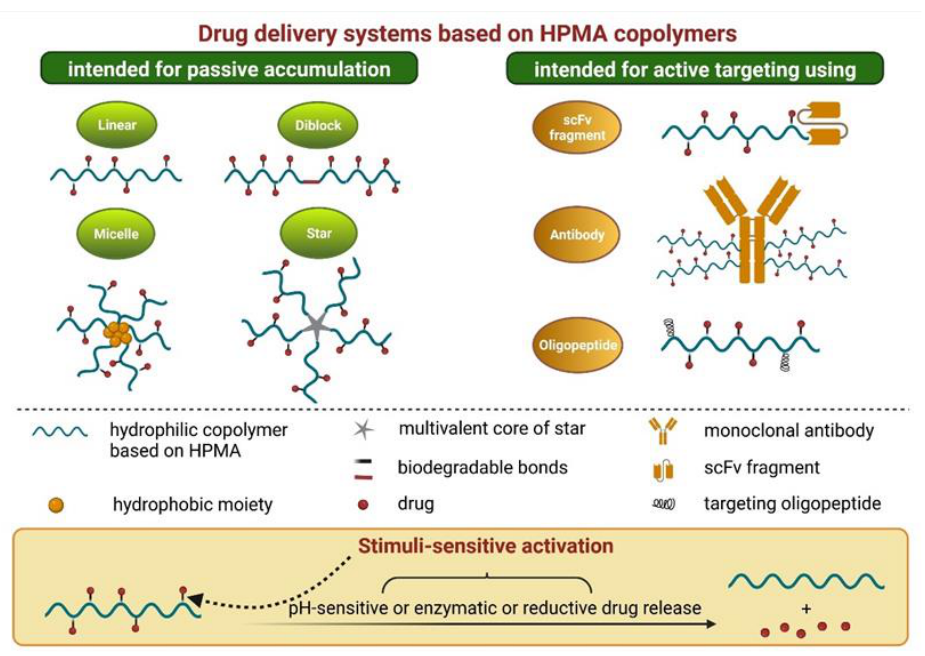
Figure 4. Overview of drug delivery systems based on HPMA co-polymers. Created with BioRender 10-DEC-2021.